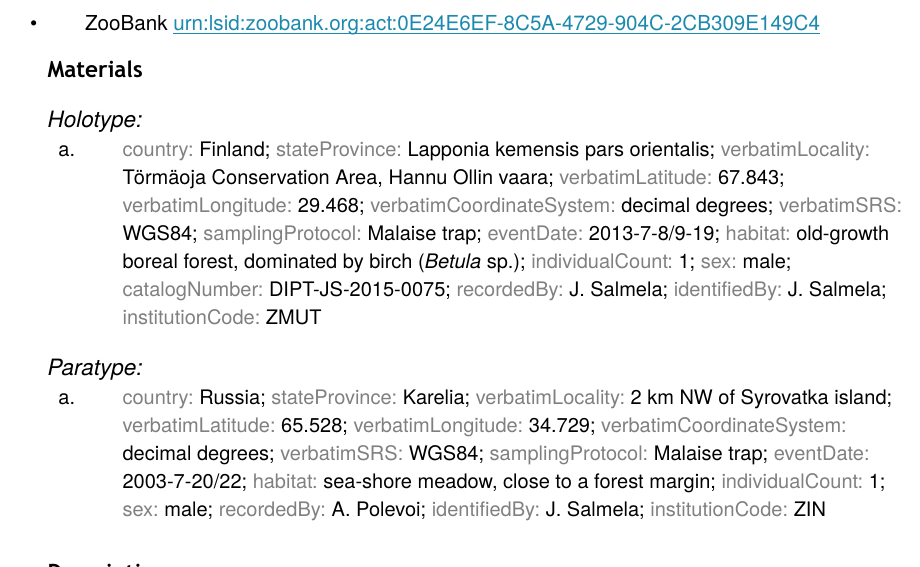
long as wide. Antennae 16-segmented (scape, pedicel and 14 fl agellomeres), black. its lateral base, having 7 minute setae. Flagellomeres cylindrical, length:width ratio of 1st fl agellomere 1.51, 4th fl agellomere 1.76 and apical fl agellomere 3.13. Flagellomeres covered by dense light setosity, setae slightly curved, their length shorter than width of respective fl agellomere; polygon-like (reticulate) pattern present, especially so in apical fl agellomeres. Thorax black. Scutum covered by pale setae. Anepimeron bare, other sclerites setose. Scutellum with eight setae in a curved row. Halteres light brown with pale setae; apical part of stem and base of knob infuscated.